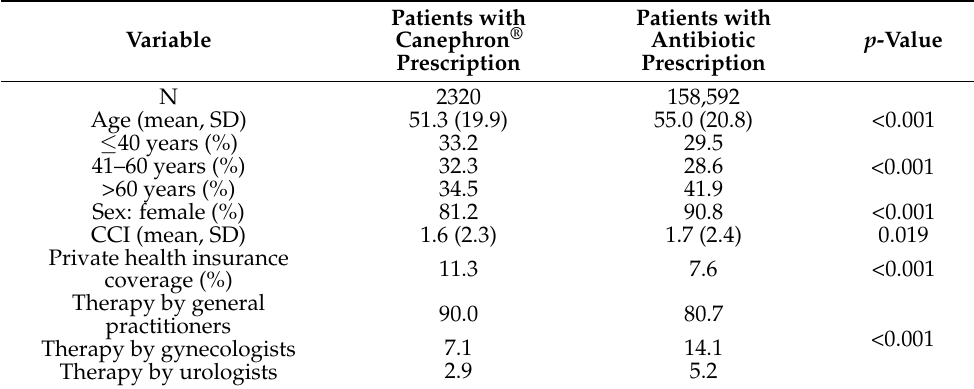
Table 1. Basic characteristics of study patients.